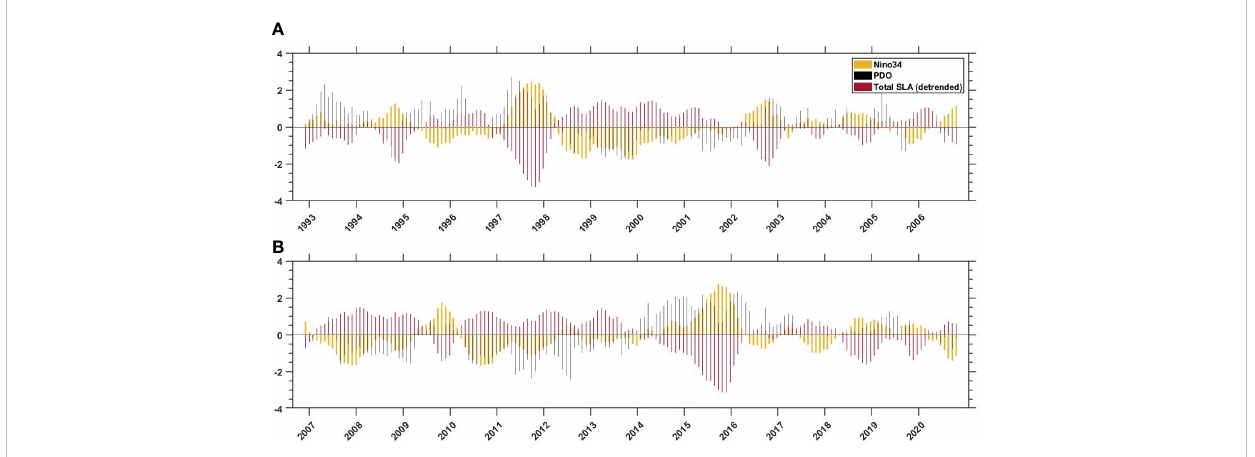
FIGURE 4 Bar plot of standardized SLA for the period 1993-2020 over the NWP (0 – 15°N; 120 E° -170° E), and the standardized ENSO Nino34 index and PDO index. For clarity, the period 1993-2020 is spit into two equal periods i.e. 1993 - 2006 as in (A) and 2007-2020 as in (B)